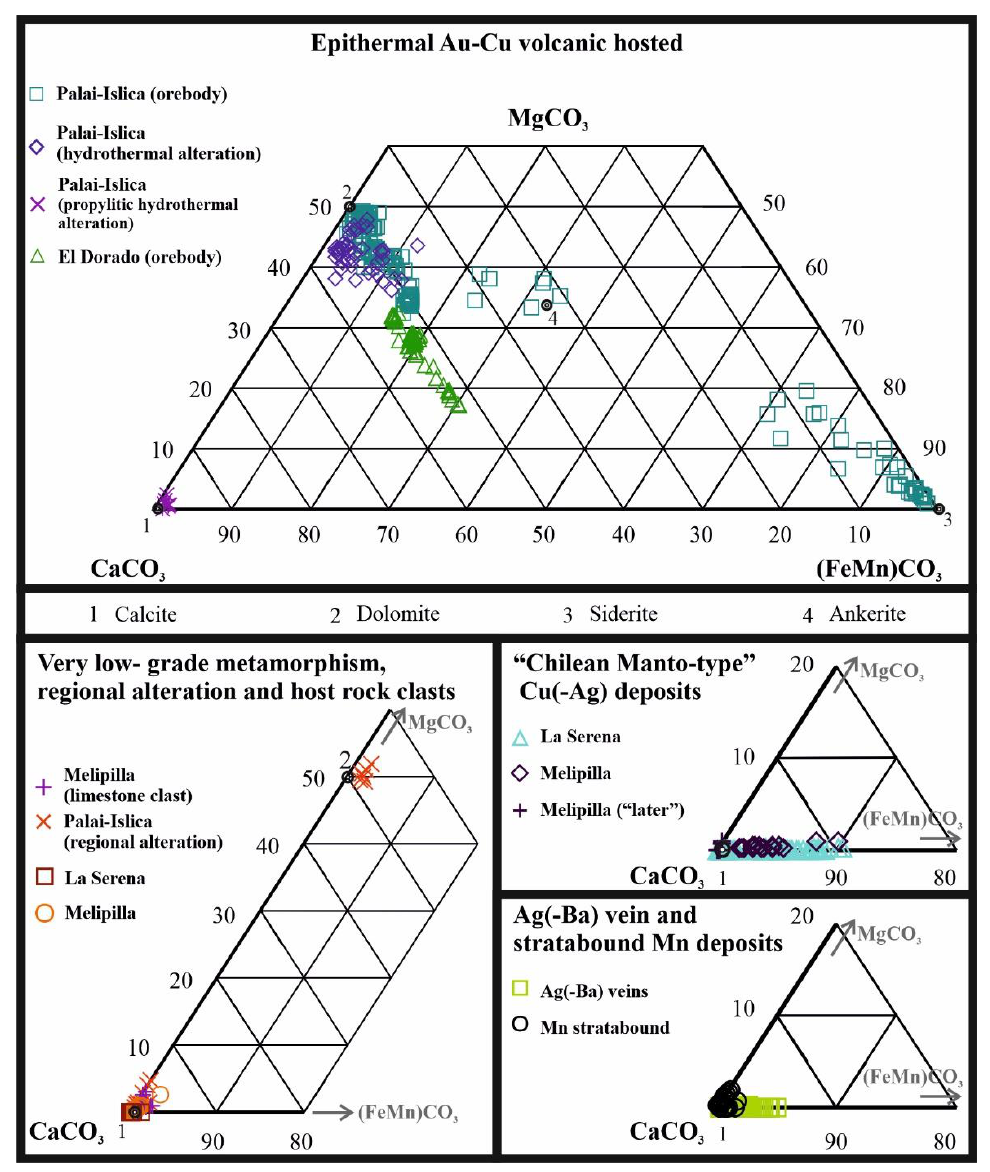
Figure 3. Triangular plot (CaCO 3 -MgCO 3 -FeCO 3 +MnCO 3 ) showing the major molar composition of analyzed carbonates. According to the carbonate type in each location, only a portion of the triangles is shown.